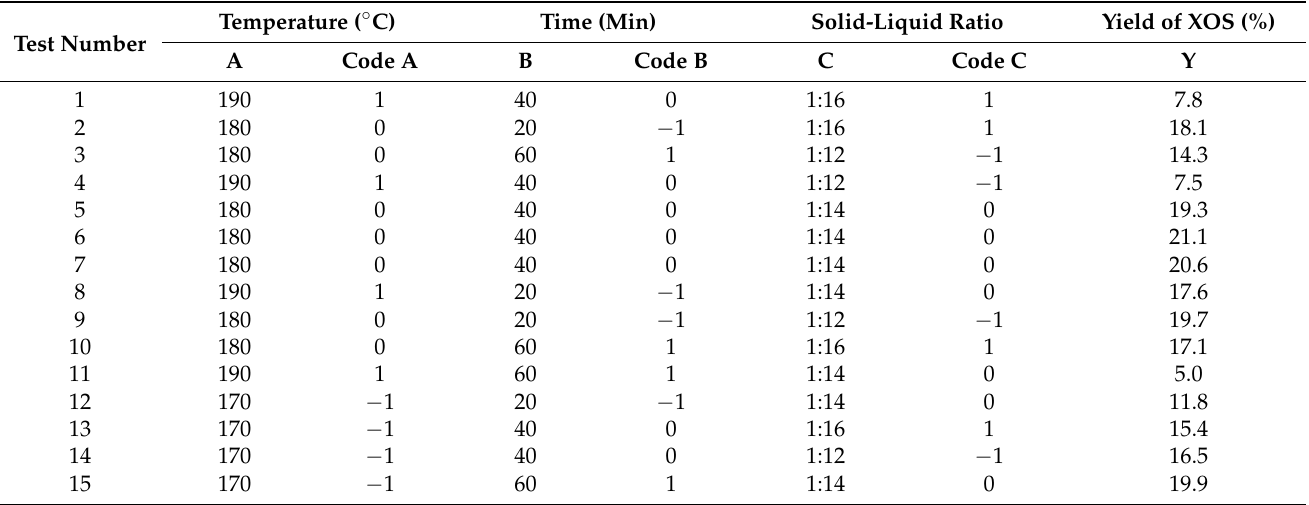
Table 1. The Box–Behnken experimental design and the responses of the dependent